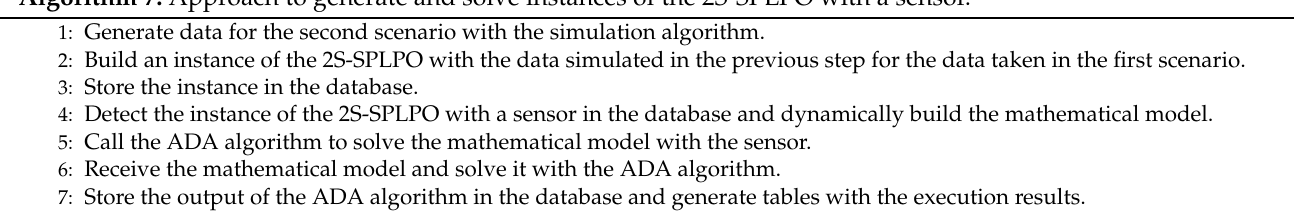
Algorithm 7: Approach to generate and solve instances of the 2S-SPLPO with a